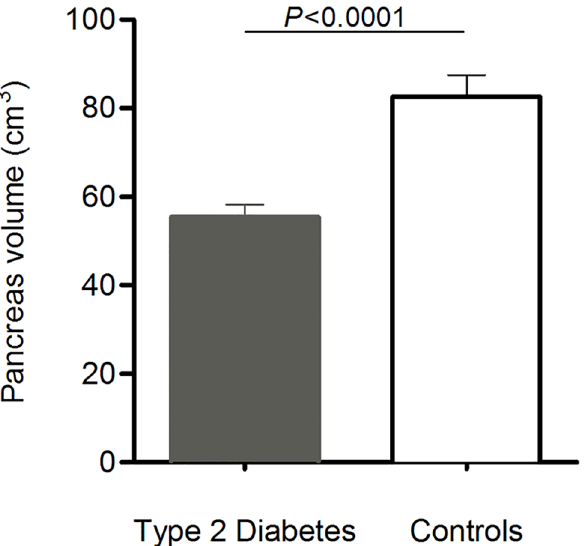
Fig 1. Mean pancreas volume in the type 2 diabetes and control groups (error bars show standard error of the mean). Pancreas volume was decreased by 33% (p < 0.001 by Mann- Whitney U